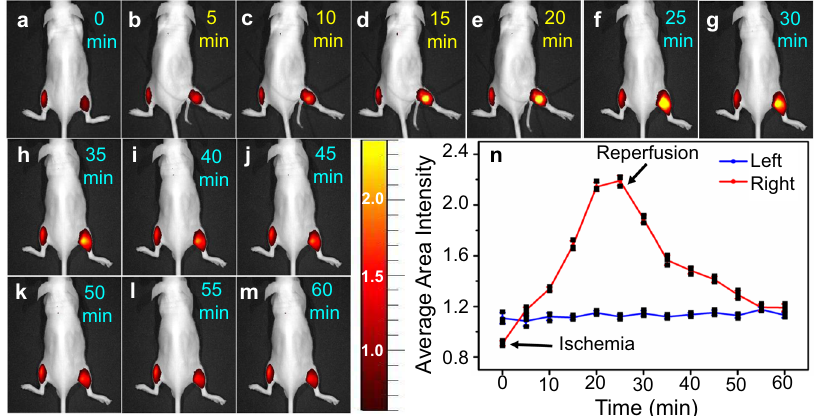
Fig. 7 Hypoxia-reoxygenation imaging in mice hind limb. Optical imaging of cycling hypoxia in ischemia-reperfusion process in a living mouse via intramuscular injection of HDSF (20 μ M, 50 μ L, 20 min) in the two hind limbs. The ischemia-reperfusion process was simulated via treating the right limb with a tourniquet for 25 min followed by removing the tourniquet thereafter. a – m images for mouse recorded every 5 min in the ischemia-reperfusion process (1 h); n temporal pro fi les for average fl uorescence intensity in the left (blue) and right (red) limbs. Data were presented as mean ± SD. The results are representative of three independent experiments. λ ex , 660 nm; λ em , 710 nm. Source data are available as a Source data fi